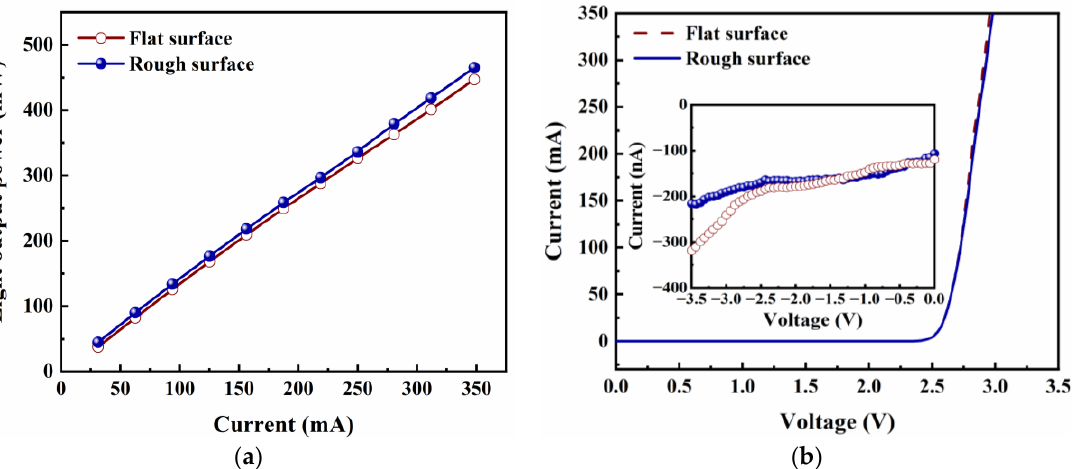
Figure 4. ( a ) LOP − I and ( b ) I − V characteristics of Si 3 N 4 -passivated LEDs with flat surface and with rough surface. The inset shows the dependence of the leakage current on reverse bias voltage of the LEDs.